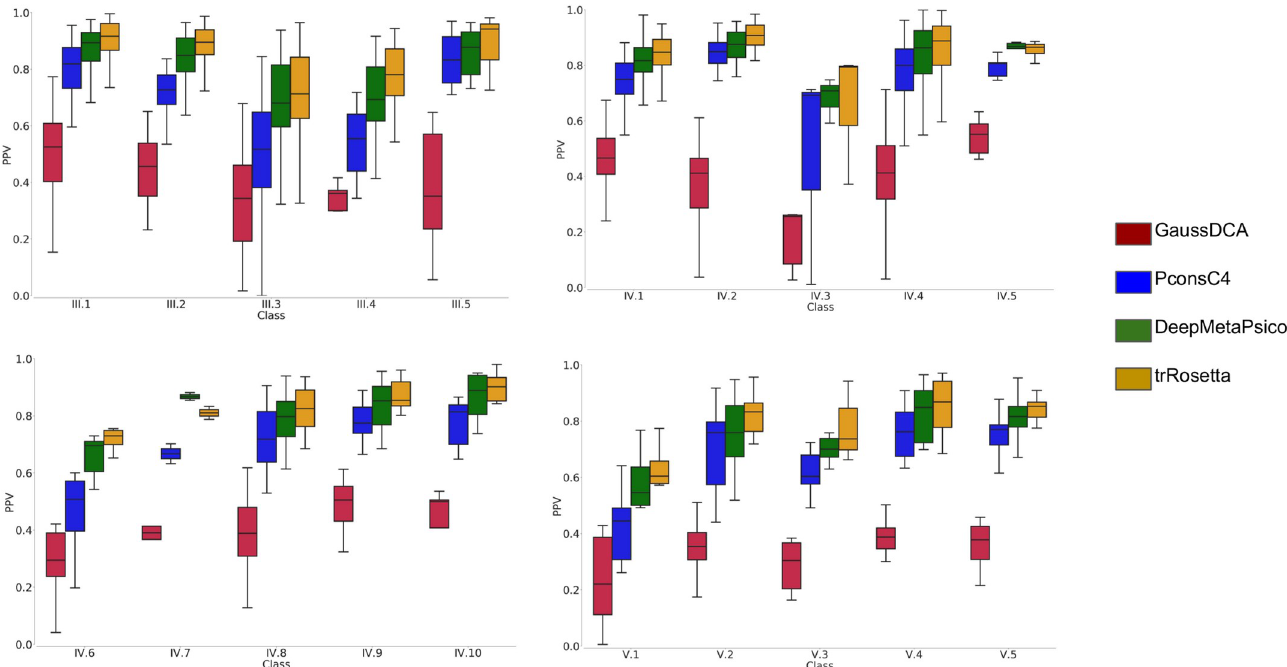
Fig 2. The precision of contact predictions. Positive Predictive Value (PPV) for the GaussDCA (red), Pconsc4 (Blue), DeepMetaPsicov (green), and trRosetta (orange).